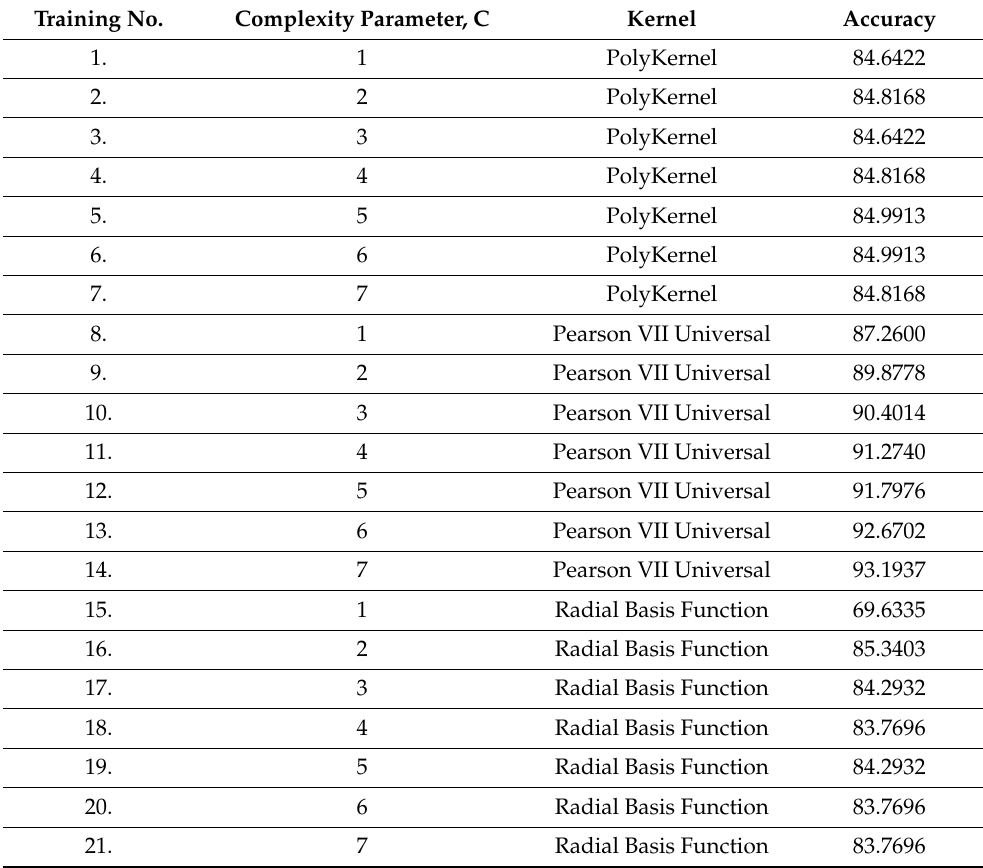
Table 8. Prediction accuracy of support vector machine hyperparameter optimization. Training